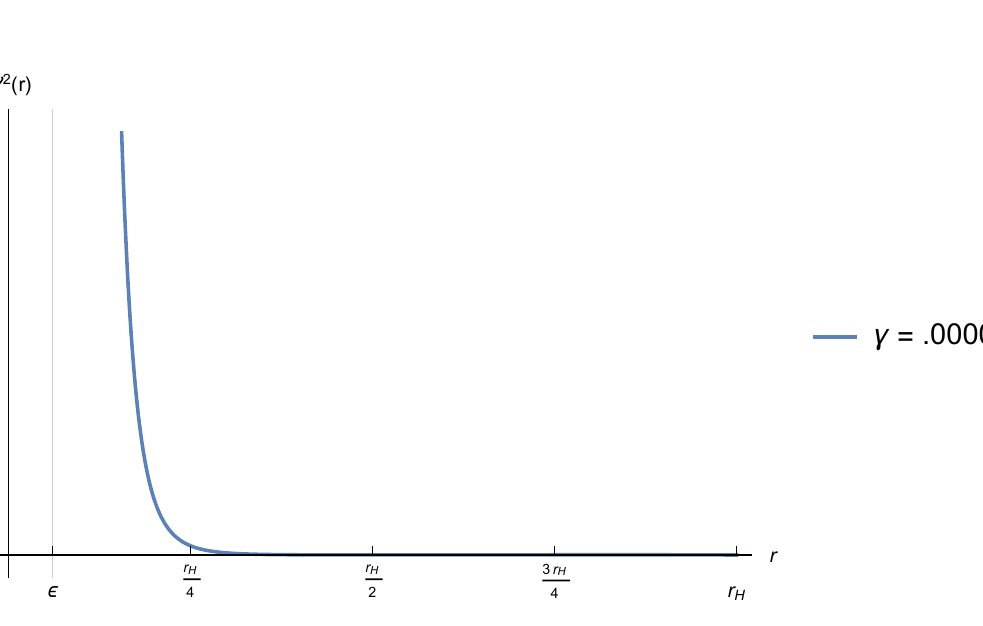
2 ( r ) of the volume functional for the α -corrected AdS-Schwarzschild Figure 16. The square V geometry in the Weyl 4 theory, with the cutoff in eq. (5.2)